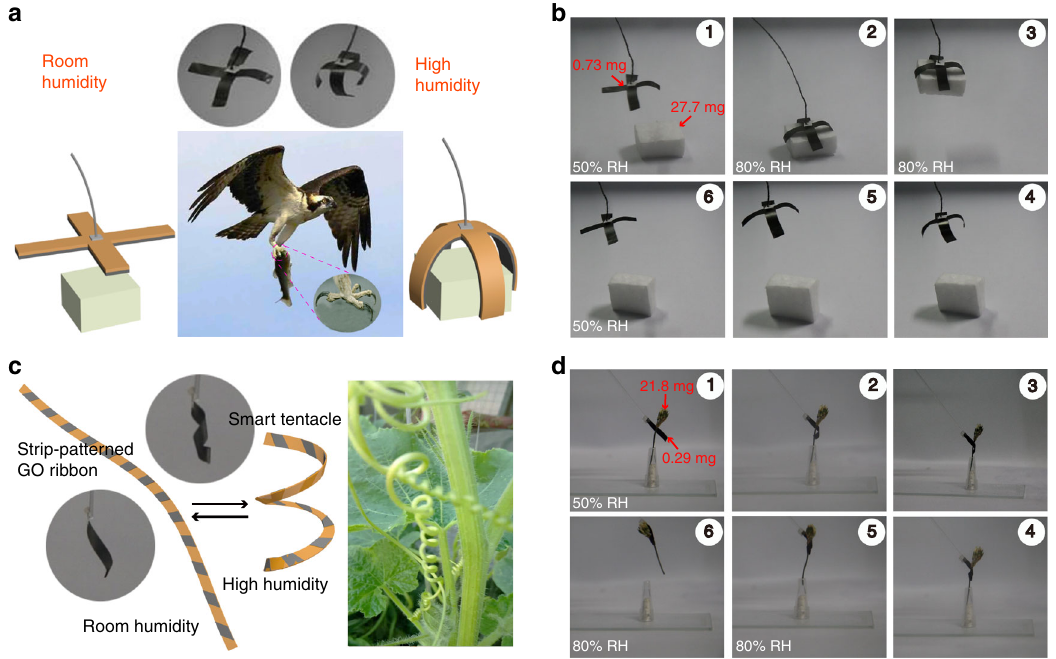
Fig. 4 Biomimetic gripper with cross and helical structure. a Schematic illustration of a smart GO/PPy gripper with a cross structure inspired by the claw of a hawk (middle image). It exhibits a straight state at room humidity ( ≈ 50% RH, left images) and a bent state at high humidity ( ≈ 80% RH, right images). b The process of a foam being picked up and released by a smart GO/PPy gripper; c schematic illustration of a smart GO/PPy tendril-inspired by a tendril climber plant (right images). The tendril curves at room humidity ( ≈ 50% RH, left images) and curls to a helical structure under high humidity ( ≈ 80% RH, middle images); d a fl ower can be removed from a homemade vase by the helical GO/PPy